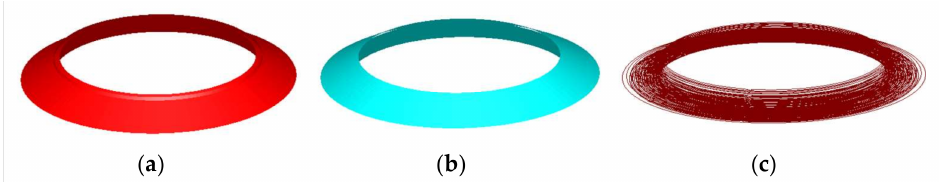
Figure 22. The third-stage forming toolpath: ( a ) the surface of the forming area; ( b ) the tool location surface; ( c ) the generated forming toolpath.